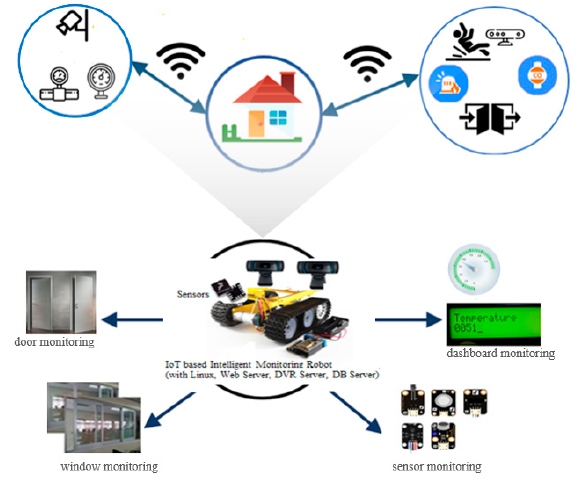
Figure 3. Framework of an IoT-based intelligent monitoring robot.